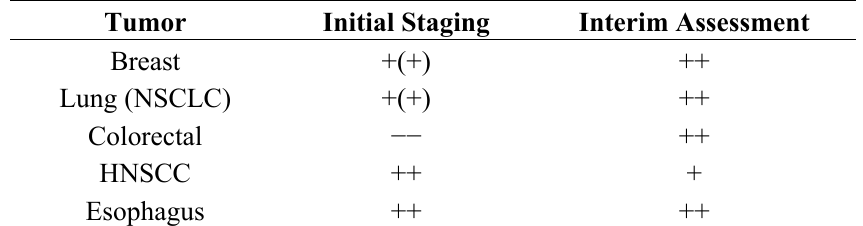
Table 2. Indications of baseline and interim FDG-PET in principal solid